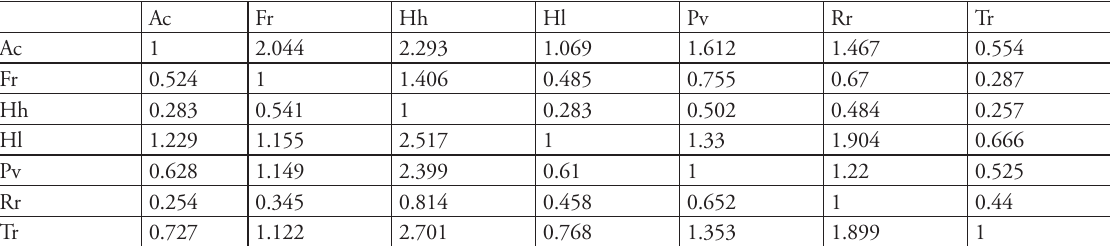
Table 1. Competition coefficients from the example calculations. A minus indicates facilitative effects of a competitor. Target species name is given in row, competitor in columns. Ac = Agrostis capillaris, Fr = Festuca rubra, Hh = Hydrocotyle heteromeria, Hl =